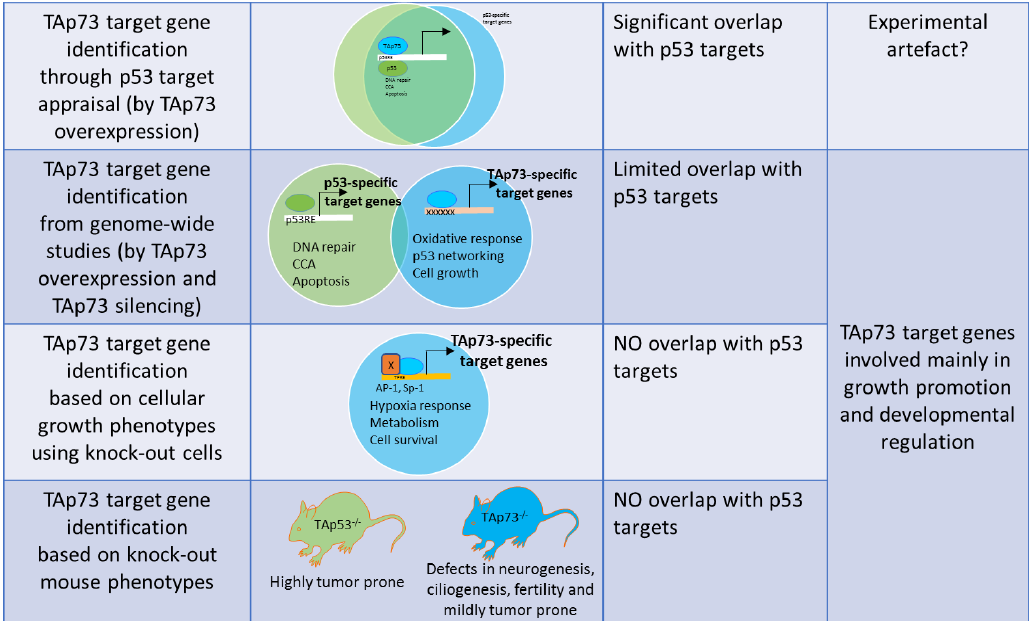
Figure 3. Overview of TAp73 target gene analyses from various studies, categorized based on the methodology broadly used for target gene identification. Venn-diagram schematically shows the extent of overlap between TAp73 versus p53 target gene. The bottom row describes the phenotypes of p53- or TAp73-null mice. p53RE: p53-response elements; TFRE: Transcription factor response element; xxxx: unknown binding sites; CCA: cell cycle arrest; X: Transcription factor.